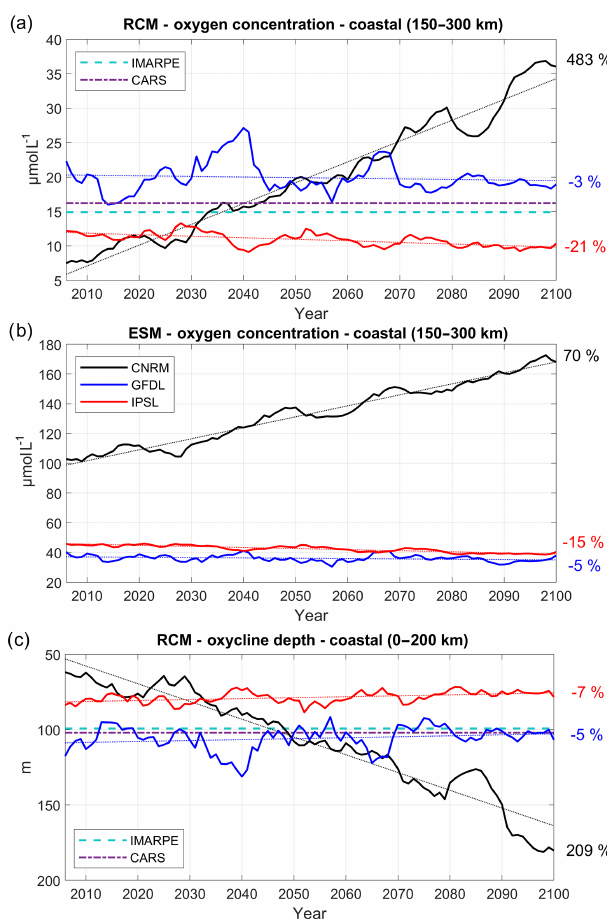
Figure 10. Oxygen concentration (µmolL − 1 ) averaged between 100 and 200m depth in a coastal box located between 150 and 300km from the coast for (a) RCM and (b) ESM; (c) depth of the oxycline (0.5–22µmolL − 1 ) isosurface averaged in a 200km wide coastal box for the three RCMs (CNRM in black, GFDL in blue, IPSL in red). The time series are filtered using a 10-year moving average. IMARPE (dashed cyan line) and CARS (dashed–dotted purple line) climatological values are also